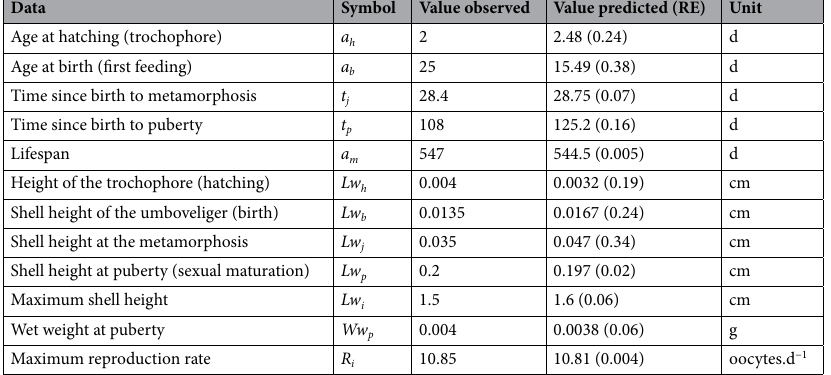
Table 1. Summary of the observed zerovariate data (life-history traits) and those predicted by the abj-DEB model of Xylonora atlantica. RE relative error; d days.